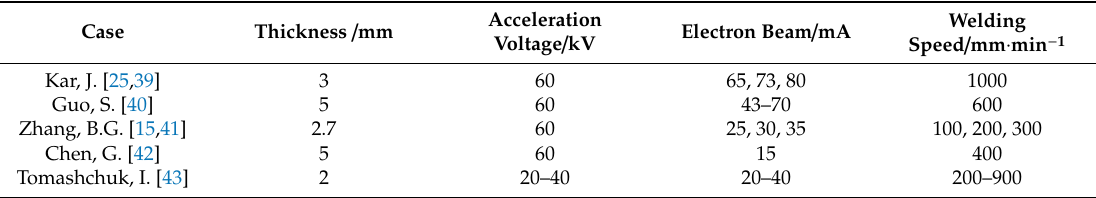
Table 1. Several cases of electron beam welding parameters of copper-steel.